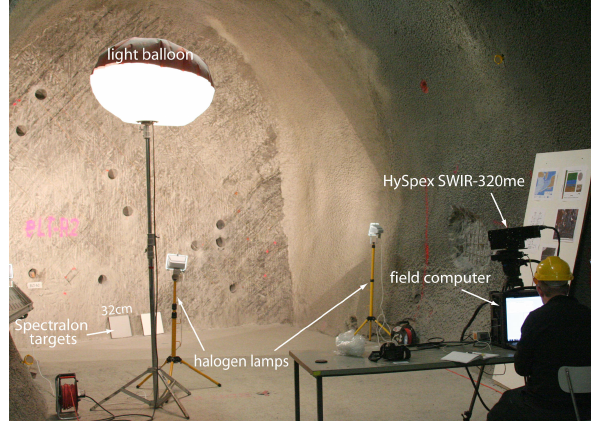
Figure 6. Scanning setup in the subsurface rock laboratory.